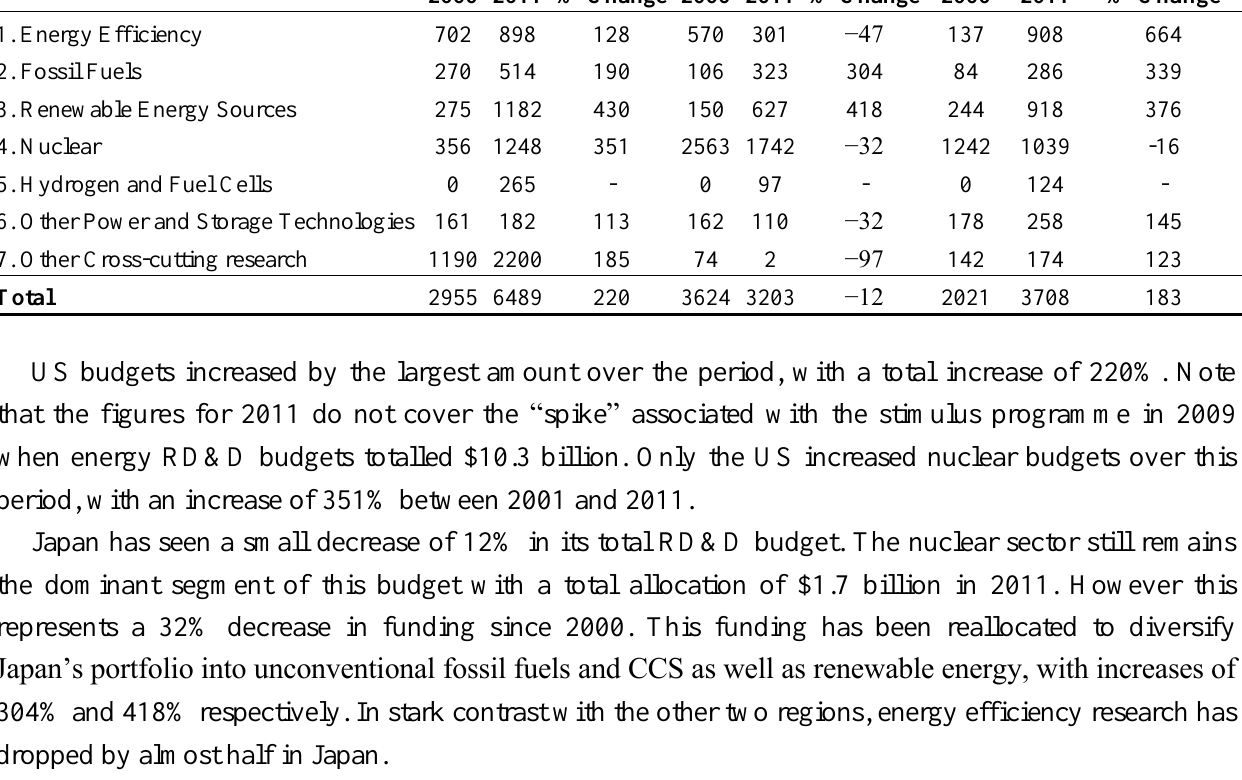
Table 3. RD&D Budgets and percentage changes for research areas 2000–2011 [3]. Research